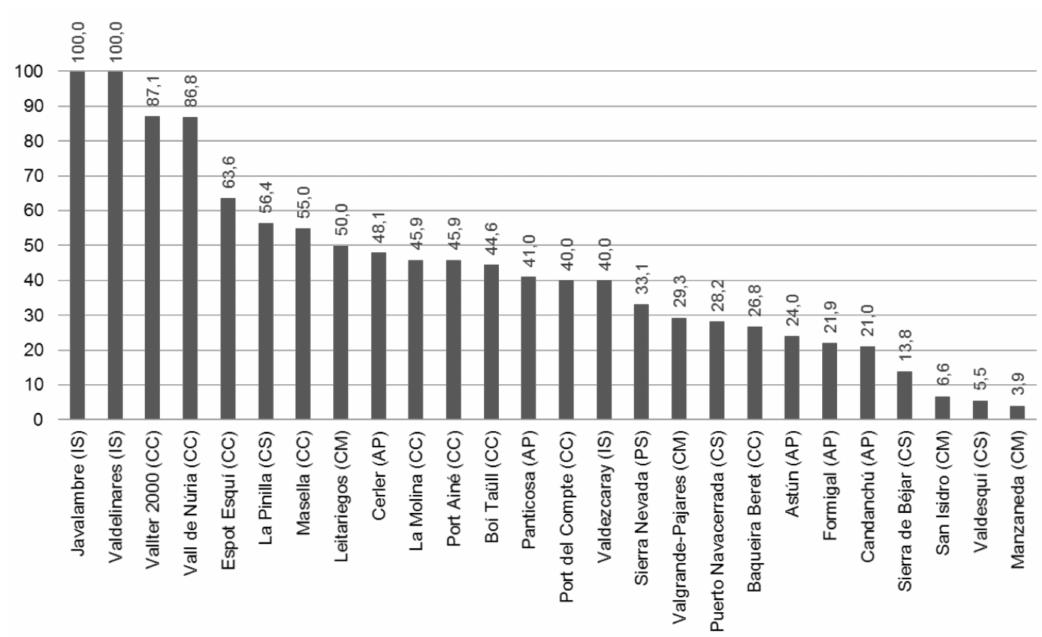
Figure 3. Artificial snow over total length of runs, winter season 2014/2015 (%). Source: ATUDEM [33]; http://www.lugaresdenieve.com/?q=es/estacion/valdesqui (accessed in July 2017). Abbreviations stand for: CP (Catalan Pyrenees); AP (Aragonese Pyrenees); CM (Cantabrian Mountains); IS (Iberian System); CS (Central System); and PS (Penibaetic System). Note: Information for the resorts of Tavasc á n-Pleta del Prat, Alto Campoo, Fuentes de invieno, Lunada, and Punto de Nieve Sta. In é s is not available.